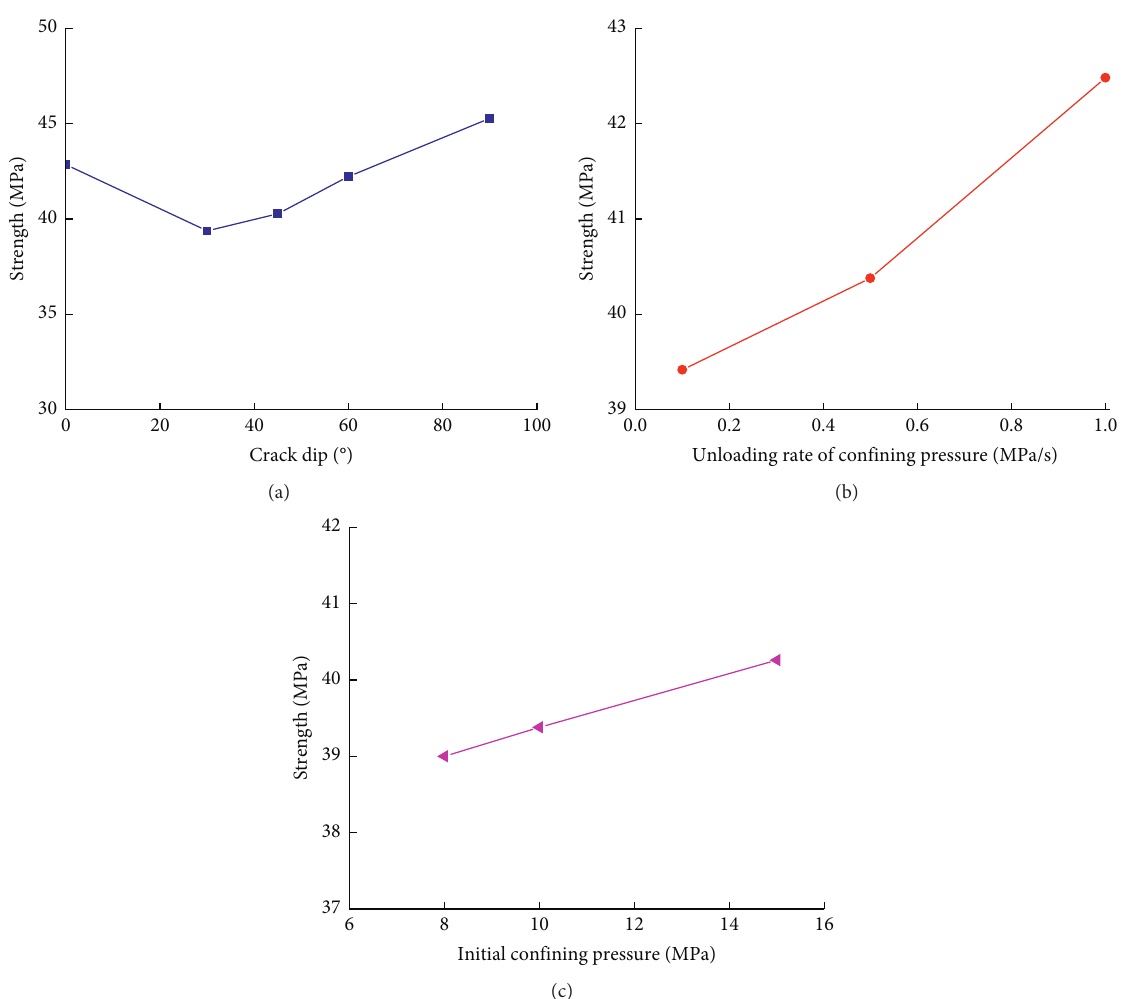
Figure 7: Peak strength of cracked specimens under axial unloading and radial unloading conditions. (a) Strength-crack dip. (b) Effect of unloading rate of confining pressure. (c) Effect of initial confining